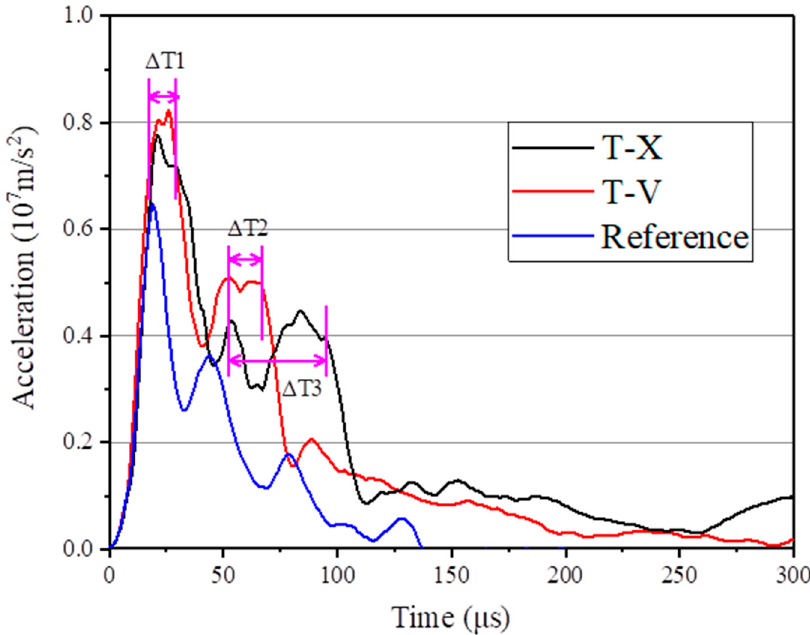
Figure 15. Time history of projectile acceleration during the penetration.